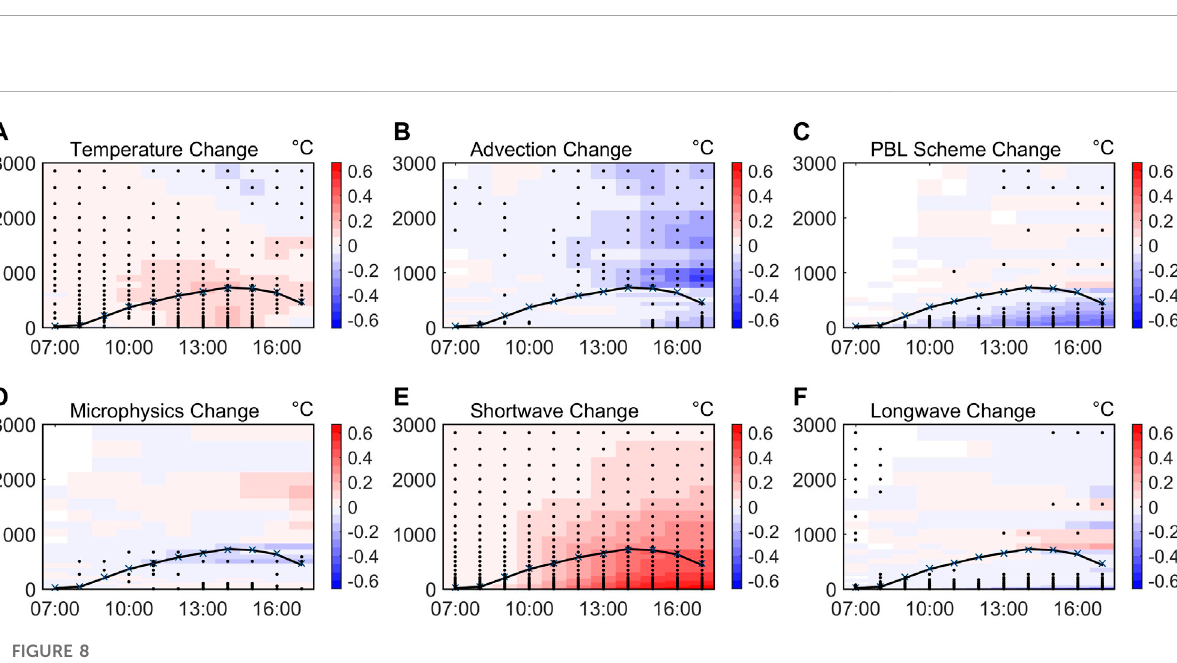
FIGURE 7 Timeseriesofensemblemeanverticaldistributions(time-heightsection)ofvariablesintheShanghaicase,averagedovertheboxregionshown in Figure 3D. (A) Simulated cloud fraction. (D) Simulated BC concentration. (B , C , E , F) Change of simulated cloud fraction, relative humidity, temperatureandwater vapor mixingratio caused byBCradiative effect, respectively. Black solidlines represent PBLheightinthesimulationwith BC radiative feedback (BASE300). Blue crosses represent PBL height in the simulation with aerosol radiative feedback except BC. (AeroRadexBC). Stilted grids indicate signi fi cant differences at the 5% signi fi cance level.